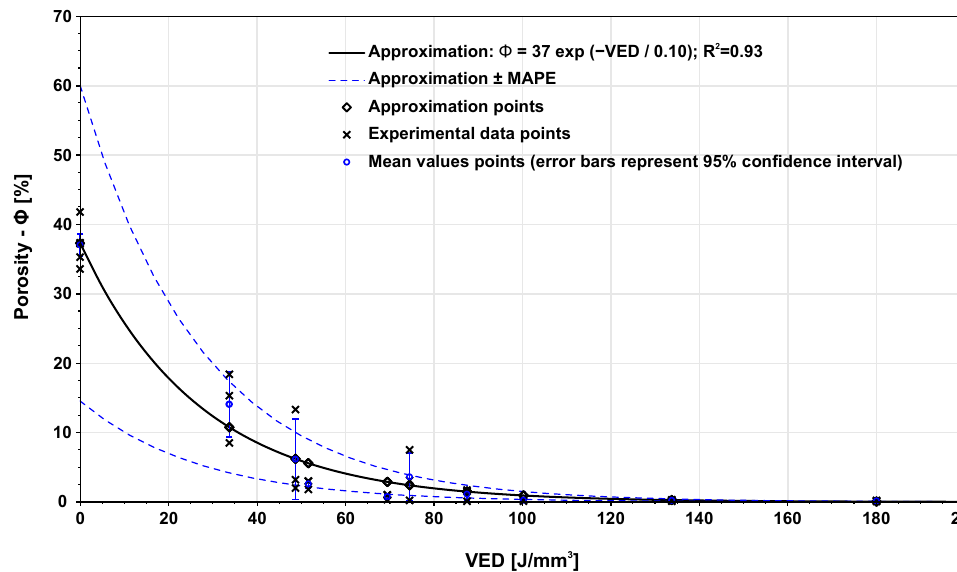
Figure 9. Mathematical relation between porosity and applied VED. Figure 10 shows the influence of VED on hardness. In the figure, it is possible to see that with rising VED the hardness also increases. From the VED value of 87.5 J/mm 3 , hardness values are more stable and approach 600 HV. For lower energies, the hardness is lower in the case of higher porosity, and it create less resistance to the indenter. The data were approximated using Equation (7). To extrapolate the influence of hardness on VED, fixed value 0 HV30 for non-melted powder was used.